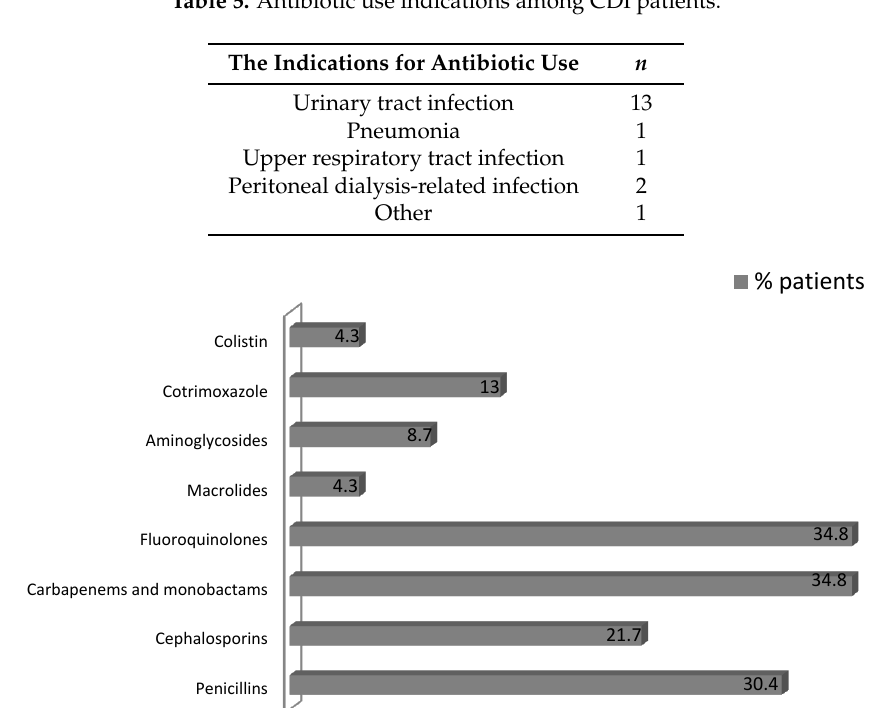
Table 5. Antibiotic use indications among CDI patients.